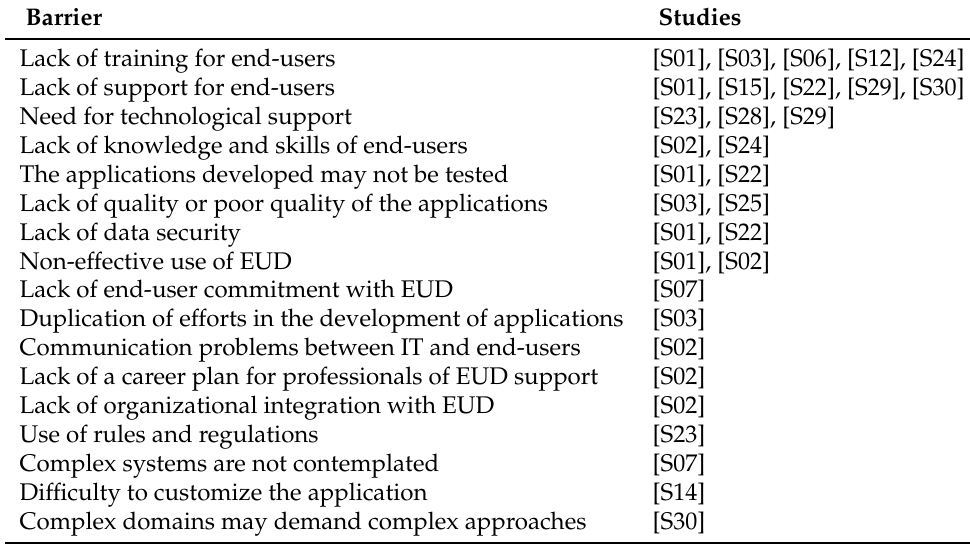
Table 4. SQ3—List of barriers. Barrier